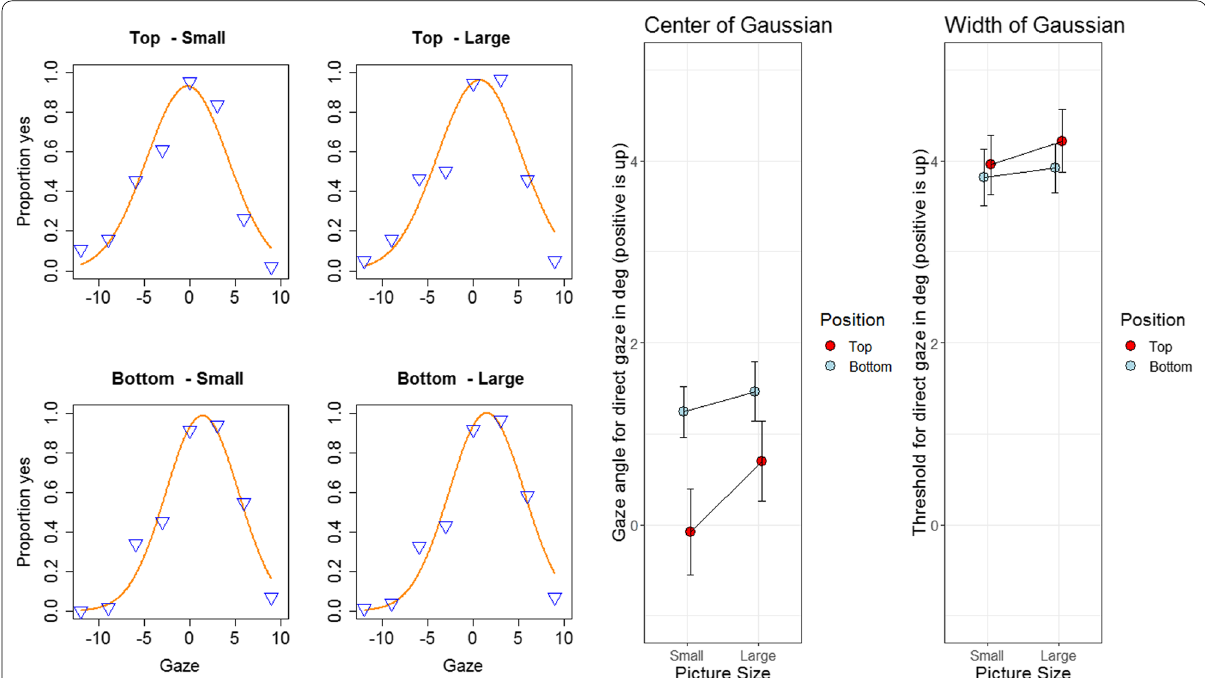
Fig. 3 Left: the grand mean data points and a graphical depiction of the fitted Gaussians. Middle: center of the Gaussian, separately for each combination of picture position and picture size. Right: width of the Gaussian, separately for each combination of picture position and picture size